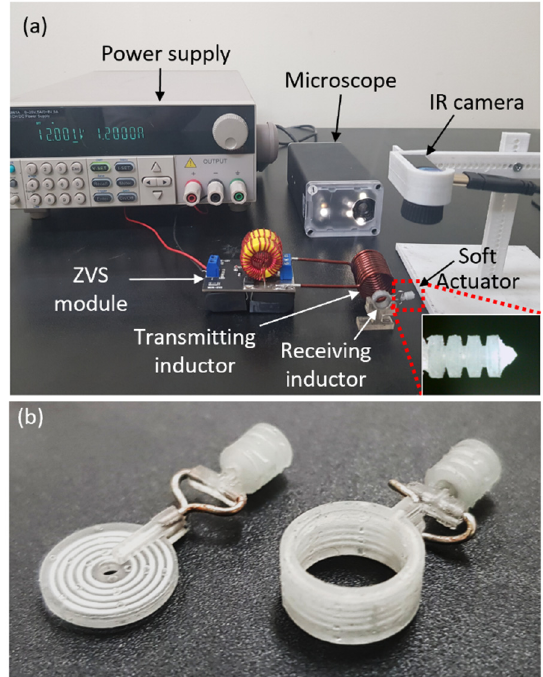
Figure 5. Measurement setups for the wirelessly powered bellows actuator characterization: ( a ) Experimental configuration measuring the operation of the soft bellows-shaped actuator with an optical microscope. ( b ) The soft bellows-shaped actuator has a built-in heater that is connected to the receiving inductor by wires.